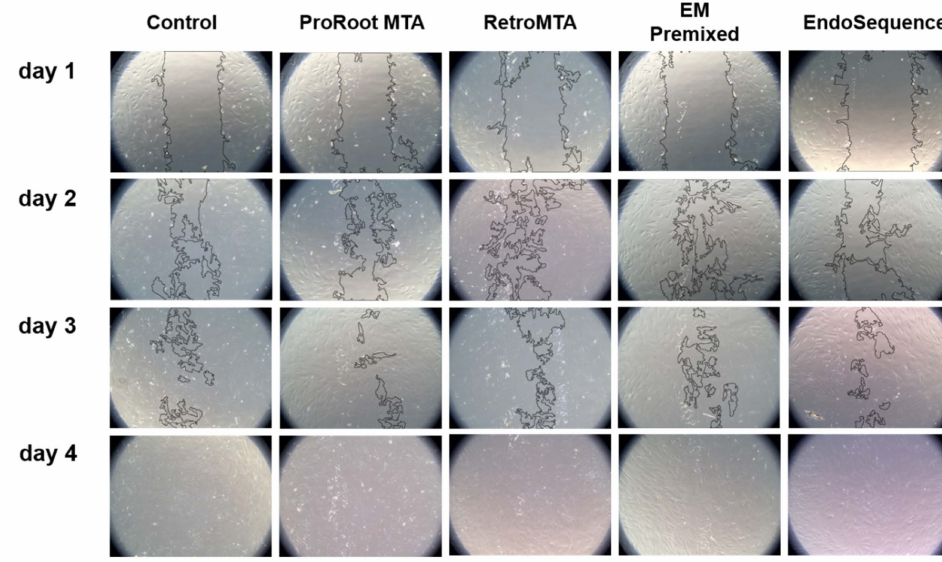
Figure 4. Representative images of cell migration assay. Black lines indicated that cells were migrated from both sides into the scratch area in the